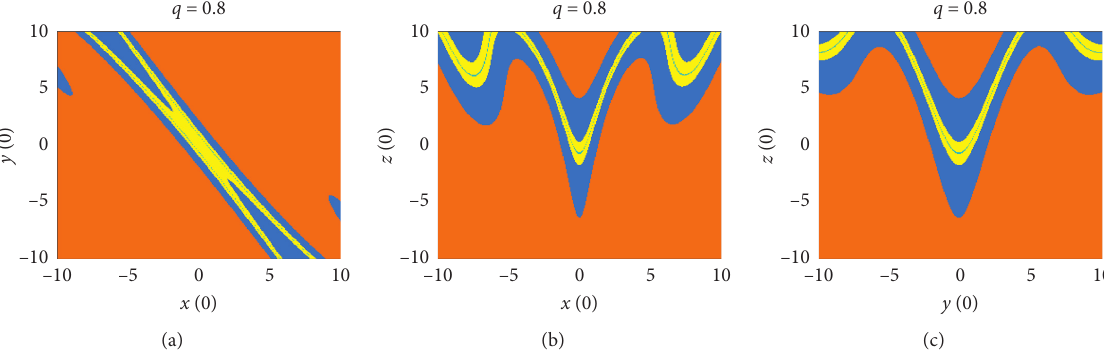
Figure 11: The basin of attraction of system (1) with q � 0.8: (a) x (0) − y (0) plane, (b) x (0) − z (0) plane, and (c) y (0) − z (0) plane.